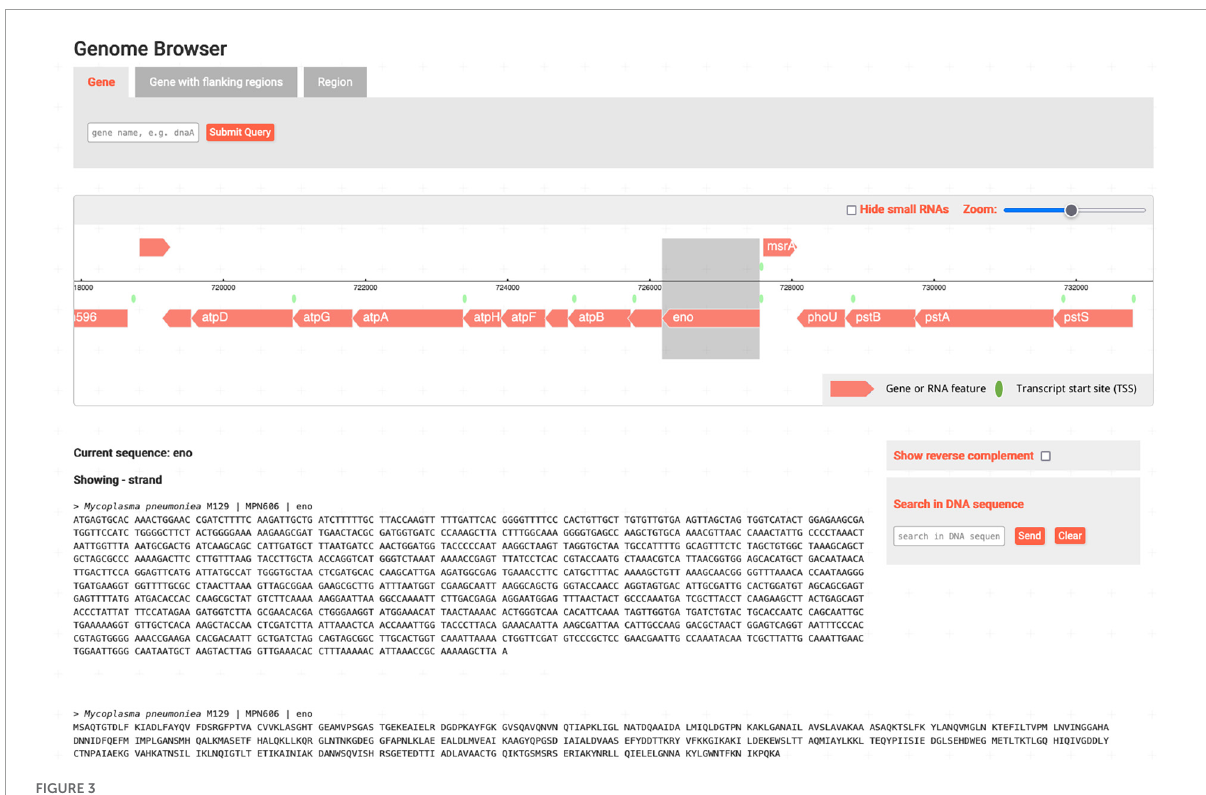
FIGURE3 Genome Browser page with eno selected. The interactive display allows to scroll through the organism’s genome and to load nucleotide and amino acid sequences of genes.